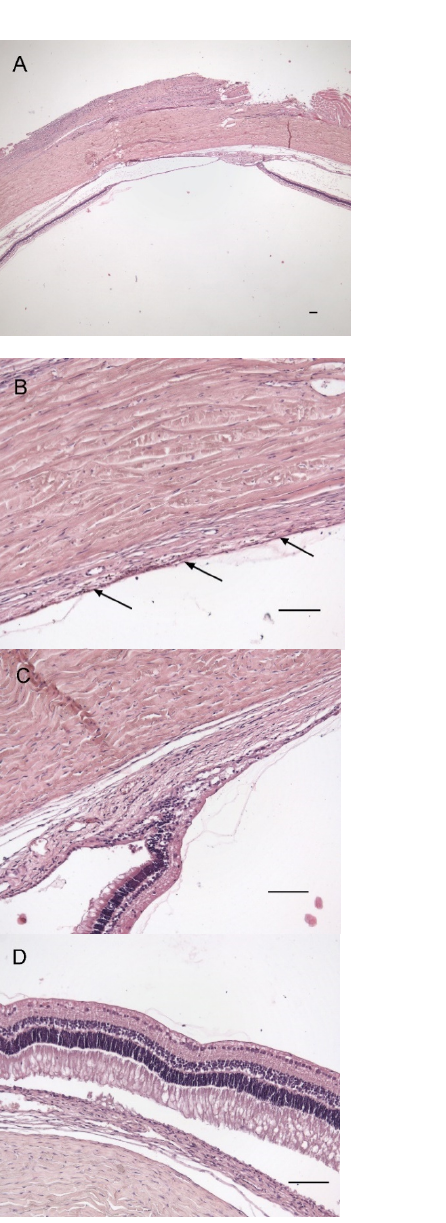
Figure 3. Histological findings: cryo group ( A – D ) and non-cryo group ( E – H ). Changes at the cryotherapy site: ( A ) intact sclera, thinned choroid, and retina partially replaced by choroidal tissue that has penetrated the disrupted pigment epithelium, ( B ) thin limiting membrane with few cells on the surface (arrows), ( C ) The transitional zone border between normal retina/choroid and a chorioretinal scar, ( D ) Intact retina and choroid outside the site of applied cryotherapy, ( E , F ) intact eyeball layers, and ( G , H ) edematous and inflammatory changes in the conjunctiva. Bars = 100 µ